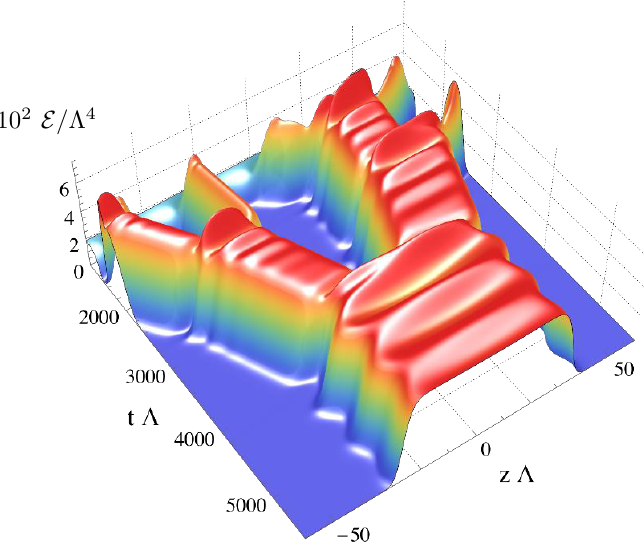
Figure 13 . Energy density of the evolution of an initial state with a box L (cid:3) = 213 perturbed with an n = 1 mode. We zoom into the region where the phase mergers take